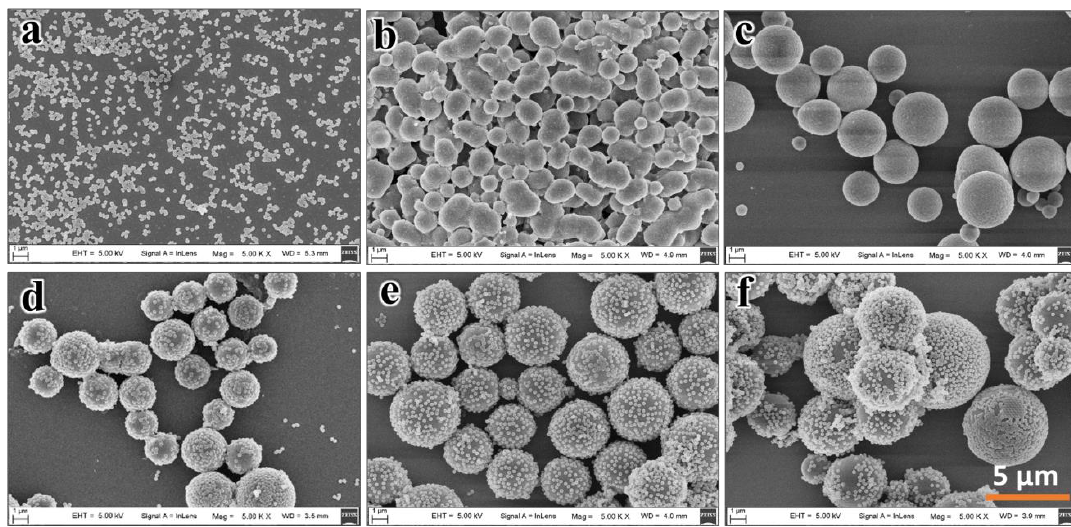
Figure 4. SEM images of HSOS particles with different mole ratios of methyltrimethoxysilane (MTMS) to 3-mercaptopropyltrimethoxysilane (SHTMS); ( a ) 0, ( b ) 2.5, ( c ) 5, ( d ) 10, ( e ) 15 and ( f ) 20, respectively.